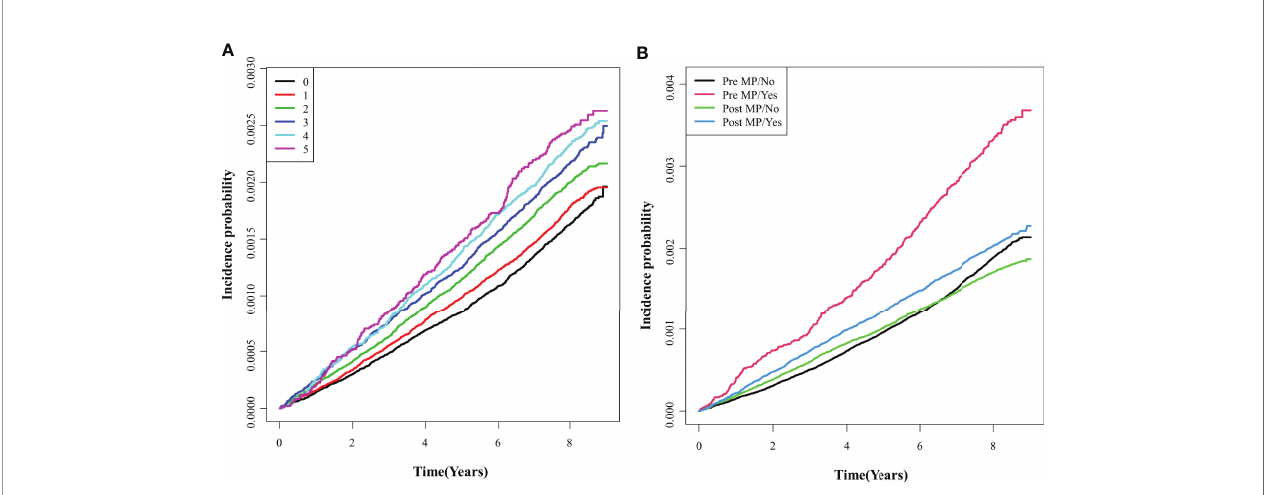
FIGURE 3 | Comparisons of endometrial cancer incidence according to the number of metabolic syndrome components. (A) Total group; (B) Pre- and post- menopausal subgroups. Pre MP/No, pre-menopausal women without the metabolic syndrome; Pre MP/Yes, pre-menopausal women with the metabolic syndrome; Post MP/No, post-menopausal women without the metabolic syndrome; Post MP/Yes, post-menopausal women with the metabolic